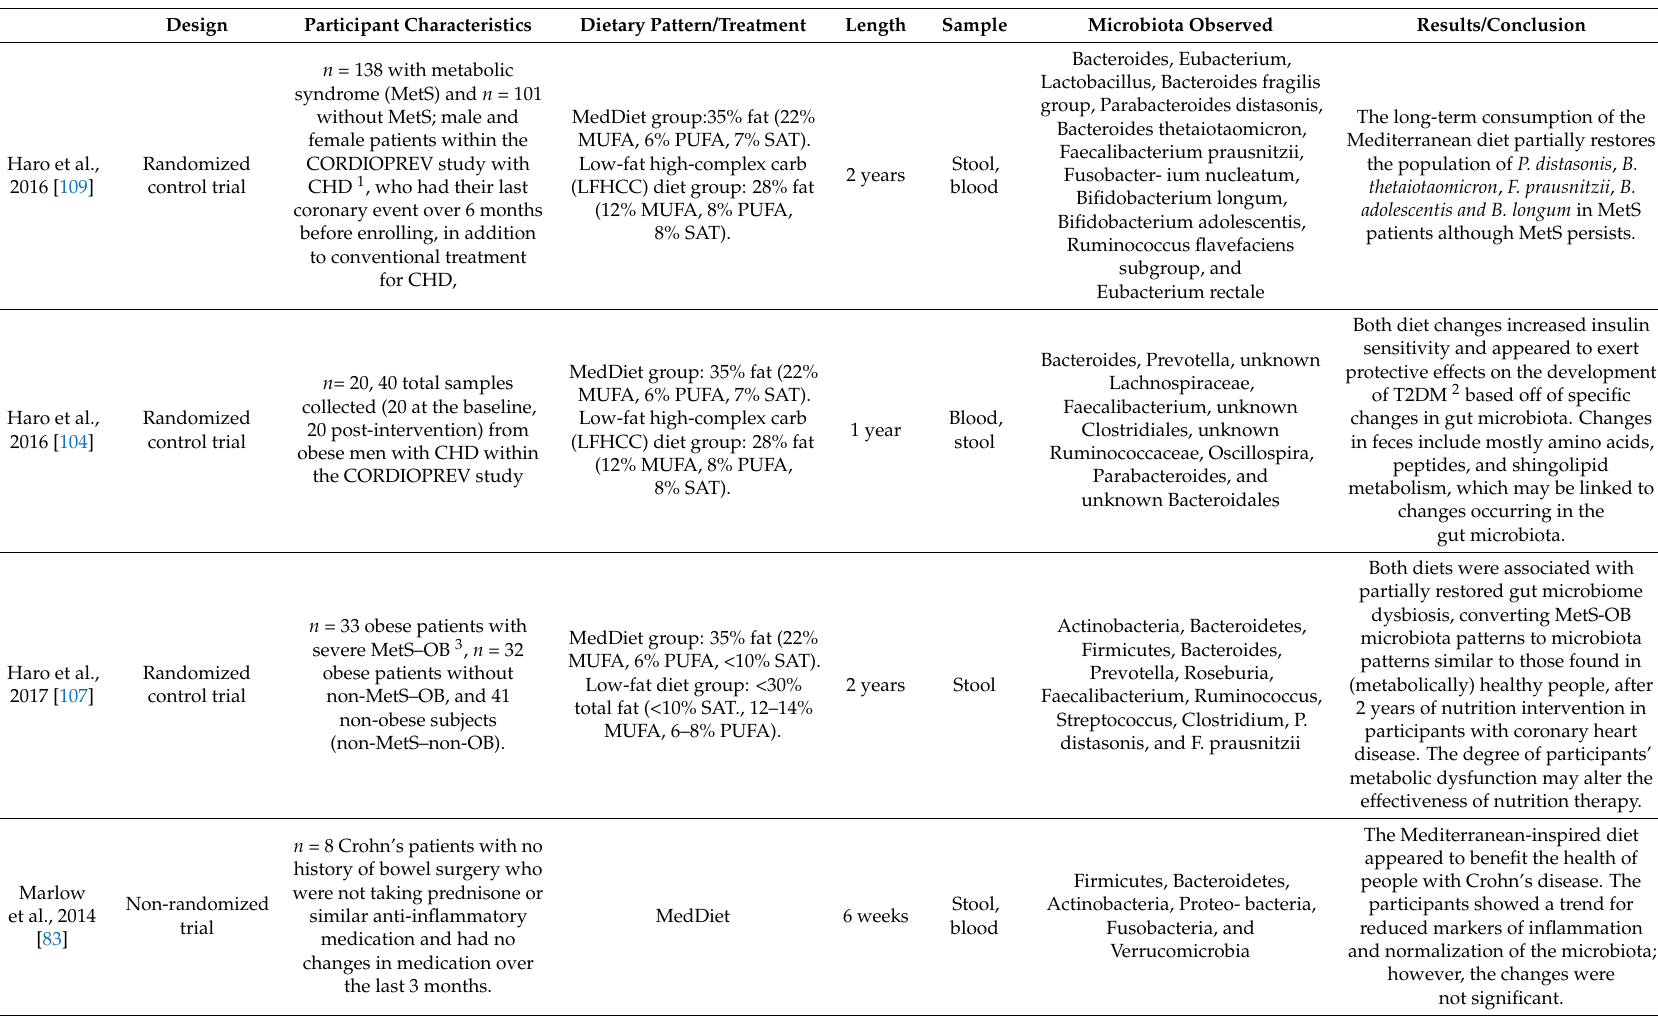
Table 4. Mediterranean diet effects on the microbiomes of diseased